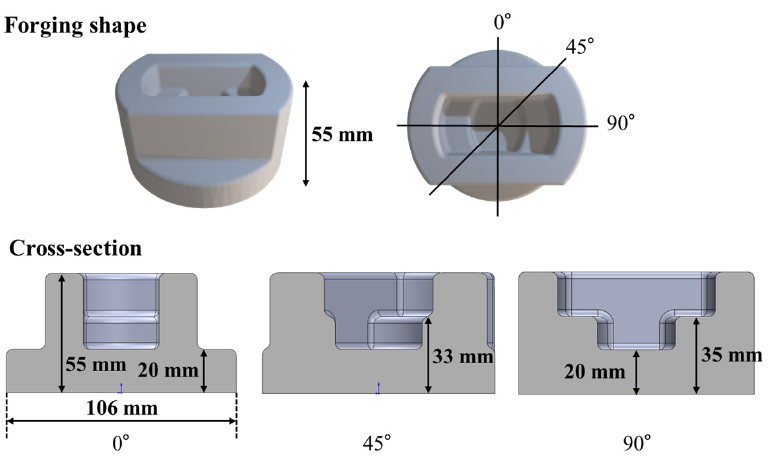
Figure 11. The1/4 plane-symmetric forging with cross-sections along 0 ◦ , 45 ◦ , and 90 ◦ directions.